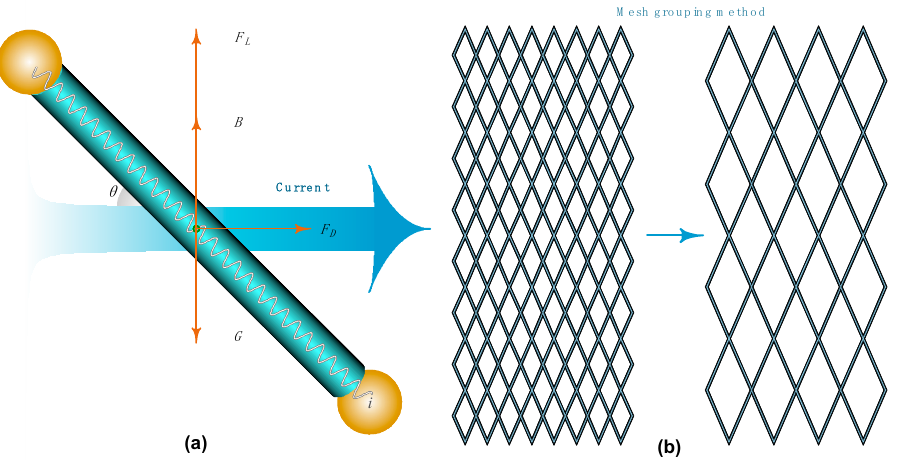
Figure 1. Illustrated interpretation. ( a ) Mechanical compositions of individual net twine in the flow. ( b ) Mesh grouping method. Netting of the mesh numbered 8 × 8 was grouped into equivalent nets with the grouping ratio r = 2 with constant mesh size.